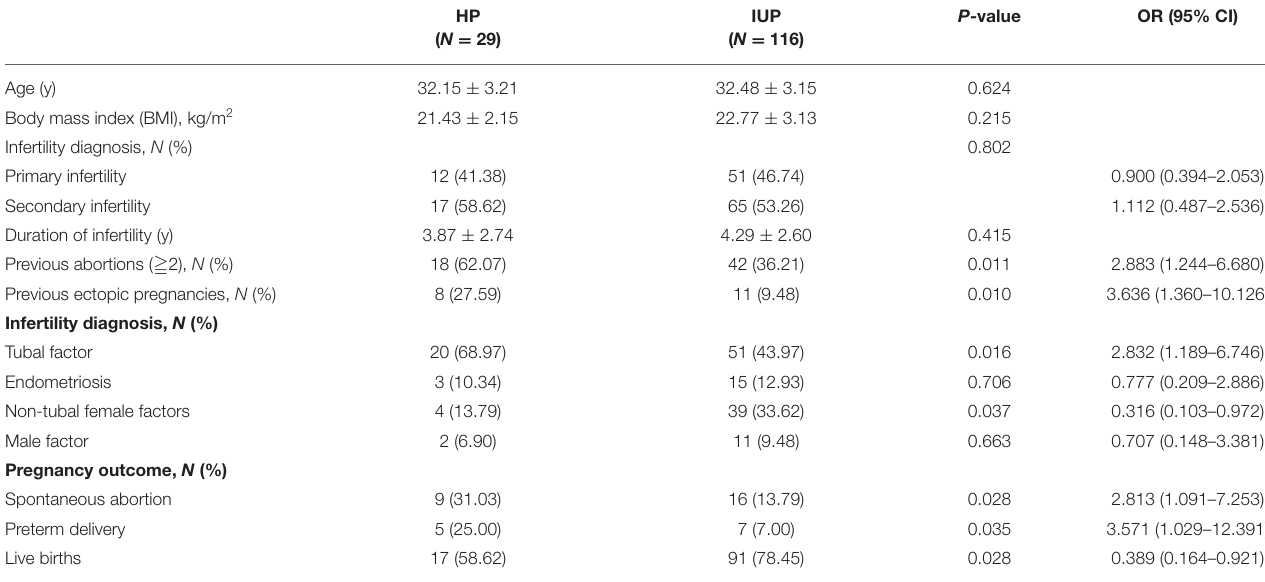
TABLE 1 | Maternal characteristics and pregnancy outcome of study population.